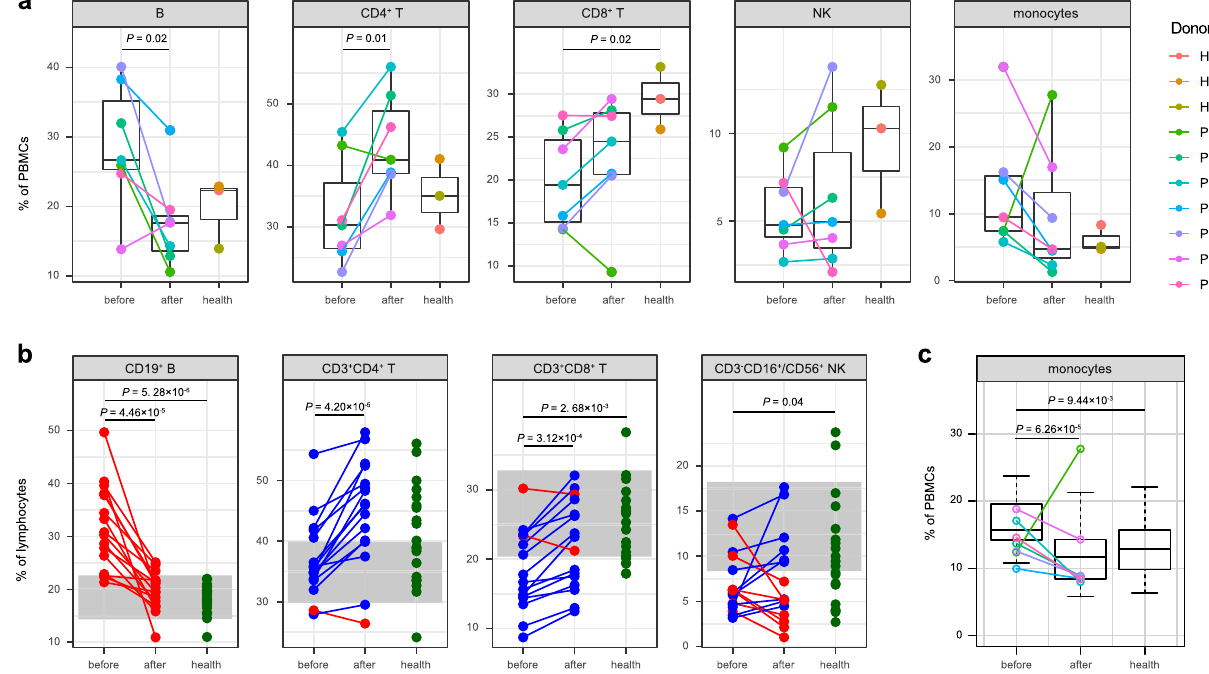
Fig. 2 Comparison of major cell types across conditions. a Percentage of each cell type in PBMCs revealed by scRNA-seq. The samples are colored according to donors. P -values are calculated between pre- and post-treatment KD patients ( n = 7) and healthy controls ( n = 3) by using the two-sided t - test. b Percentage of lymphocyte populations by fl ow cytometric validation on additional KD patients ( n = 16) and healthy controls ( n = 20). Patients with a decreased percentage after therapy are colored in red, and patients with an increased percentage after therapy are in blue. Healthy controls are colored in green. The gray areas represent the reference ranges of the panel. P -values between conditions are calculated by using the two-sided t -test. c Percentage of monocytes by routine blood test of samples collected for both scRNA-seq (KD patients n = 7) and fl ow cytometric analysis (KD patients n = 16, healthy controls n = 20). KD patients for scRNA-seq are highlighted with the same color as ( a ). P -values are calculated by using the two-sided t -test. In ( a ) and ( c ), data are represented as boxplots where the middle line is the median, the lower and upper hinges correspond to the fi rst and third quartiles, and the whiskers extend from the hinge to the farthest data point within a maximum of 1.5 × interquartile range. Source data are provided in the Source Data fi